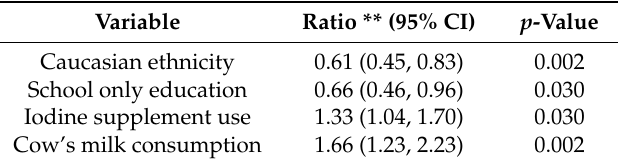
Table 3. Significant joint explanatory variables for BMIC *